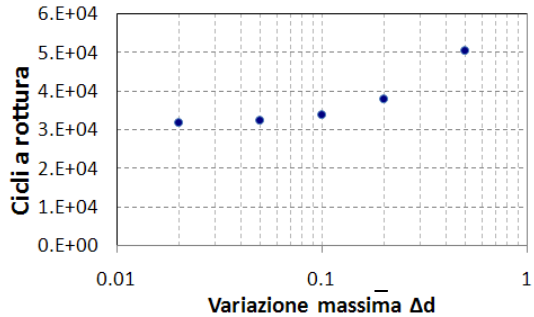
Figura 12: Influenza del valore di d Δ sulla previsione di vita a